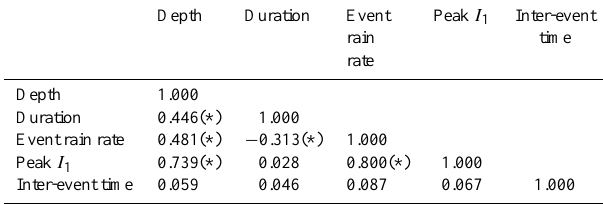
Table 2. Lower triangle of correlation matrix between the proper- ties of the selected rainfall events at Jema. The events are observed in two wet seasons that are JJA 2007 and 2008.